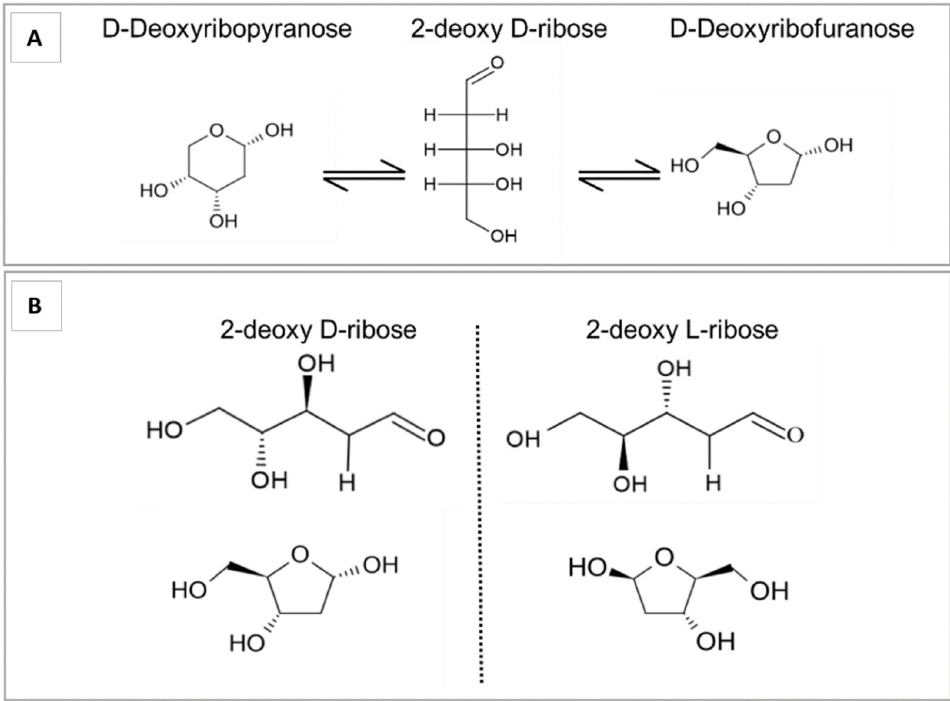
Figure 3. ( A ) Tautomeric forms of 2dDR in aqueous solution. 2dDR can exist as deoxyribofuranose, deoxyribopyranose and an intermediate chain form. ( B ) Stereoisomers of 2-deoxyribose. The asymmetric chiral carbon at position 2 leads to the existence of D and L isomers.